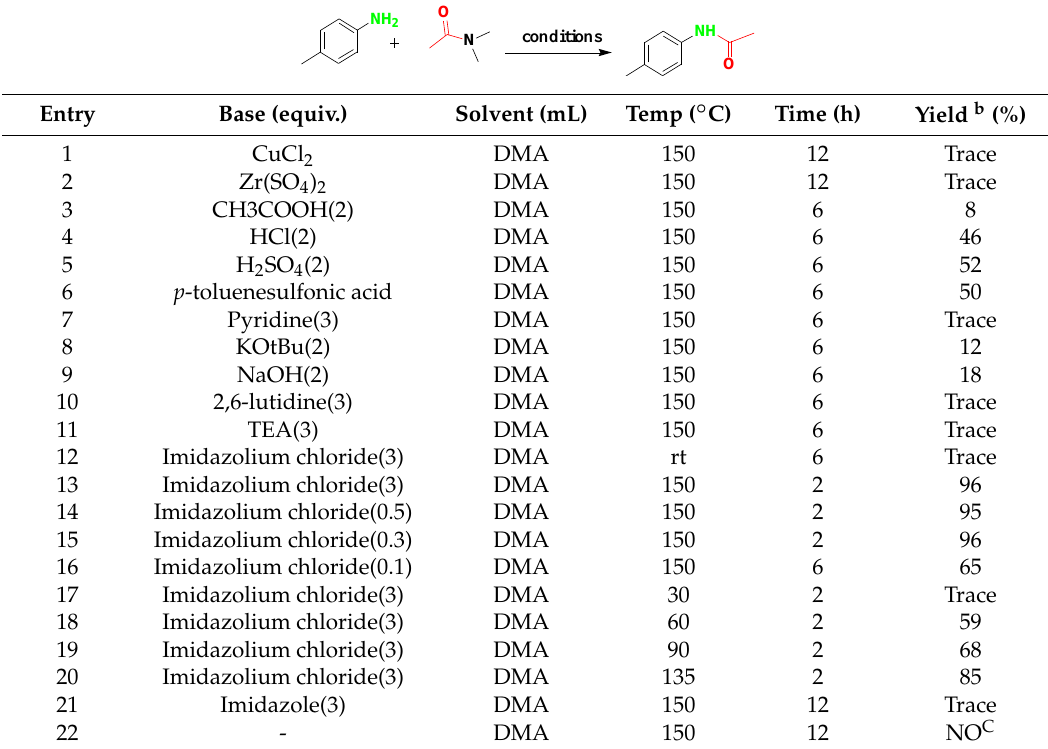
Molecules 2018 , 23 , x FOR PEER REVIEW Table 1. Optimization studies for transamidation a Table 1. Optimization studies for transamidation a .